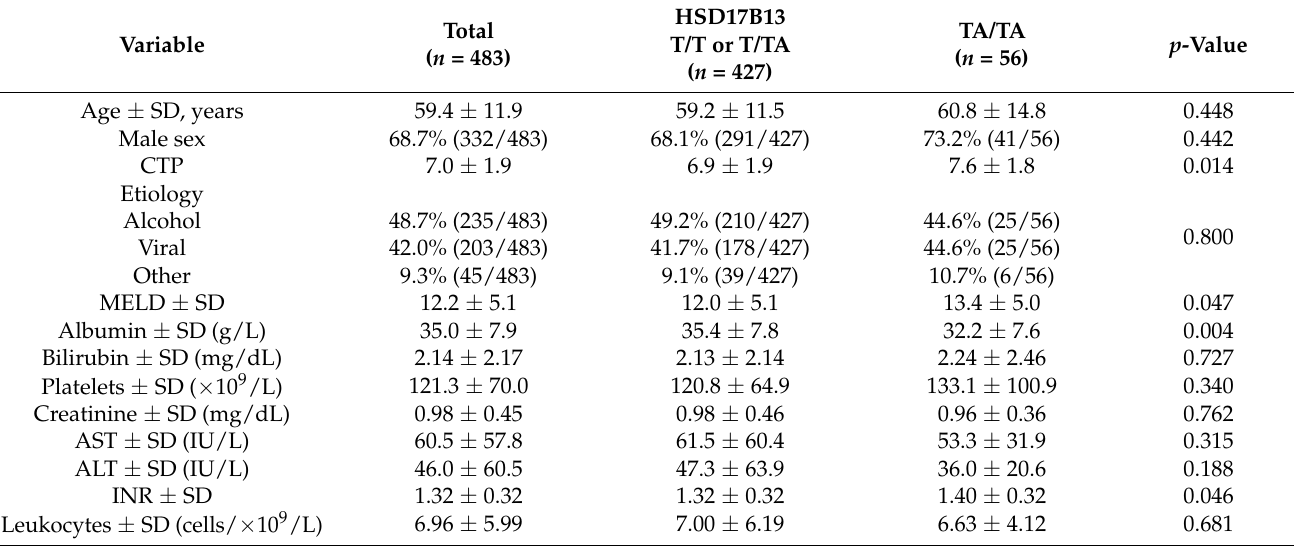
Table 1. Comparison of clinical and demographic characteristics of the patients according to the genotype of HSD17B13